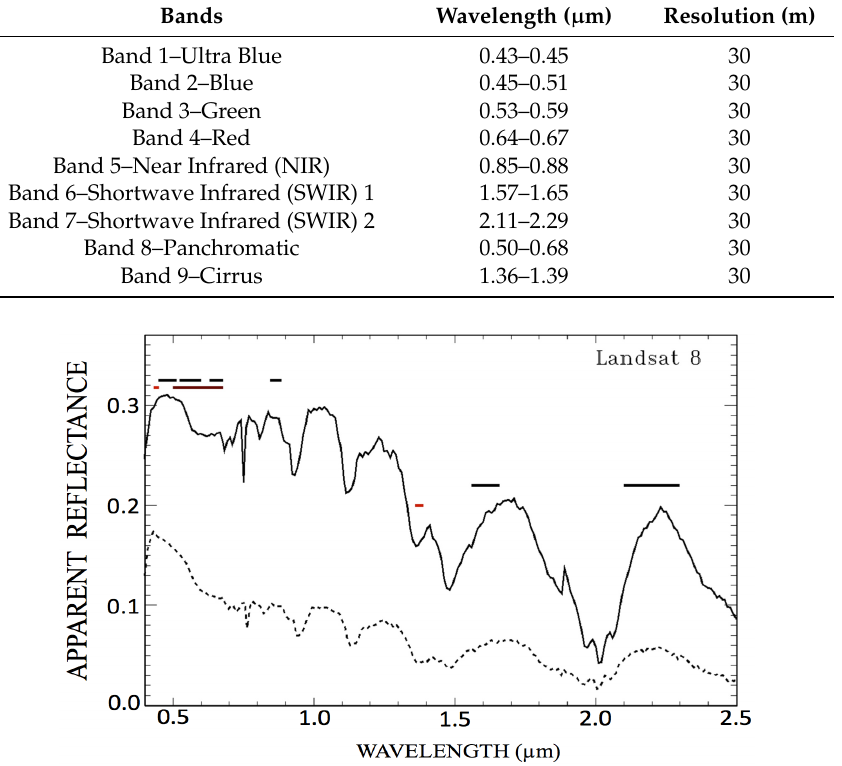
Figure 2. An illustration of Landsat 8 OLI bands and examples of Airborne Visible/Infrared Imaging Spectrometer (AVIRIS) spectra acquired over thick and thin cirrus clouds.